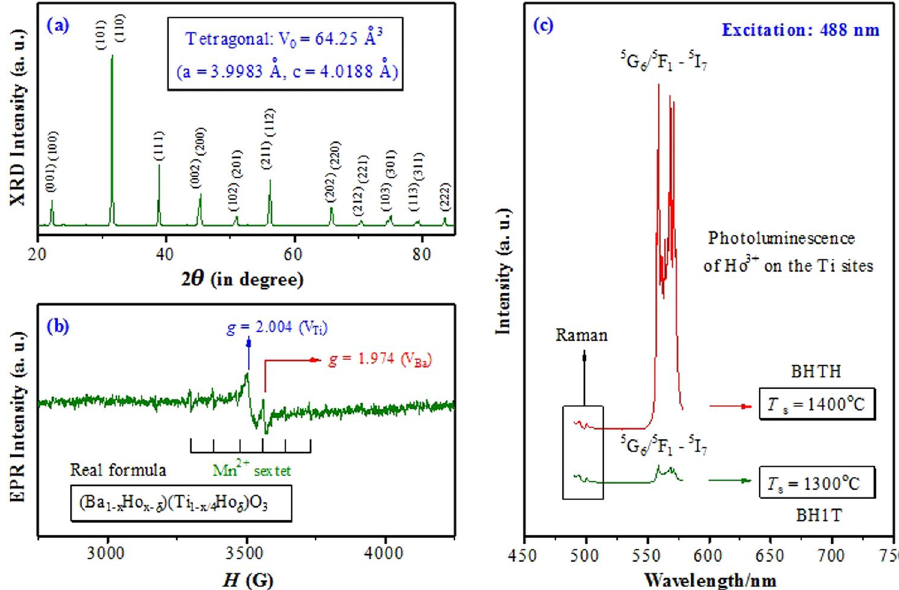
Figure 3. ( a ) XRD pattern, ( b ) EPR spectrum for the nominal (Ba 1 − x Ho x )Ti 1 − x /4 O 3 ( x = 0.01) ceramic (BH1T) sintered at T s = 1300 °C. The real formula of BH1T is approximately expressed by (Ba 1 − x Ho x − δ )(Ti 1 − x /4 Ho δ )O 3 ( δ is a small quantity) with a small number of Ti-site Ho 3 + ions. ( c ) The comparison in photoluminescence spectra between BHTH and BH1T clearly reveals that Ti-site Ho 3 + ions are responsible for 5 G 6 / 5 F 1 → 5 I 7 transition of Ho 3 +